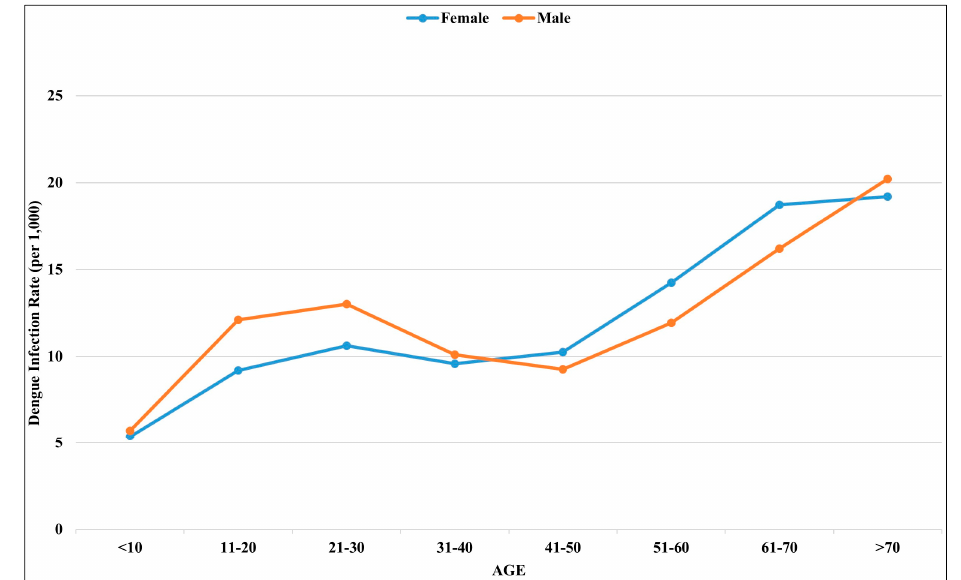
Figure 3. Age ‐ gender distribution of dengue incidence rate (per 1000) in Tainan City, 2015. Figure 3. Age-gender distribution of dengue incidence rate (per 1000) in Tainan City,